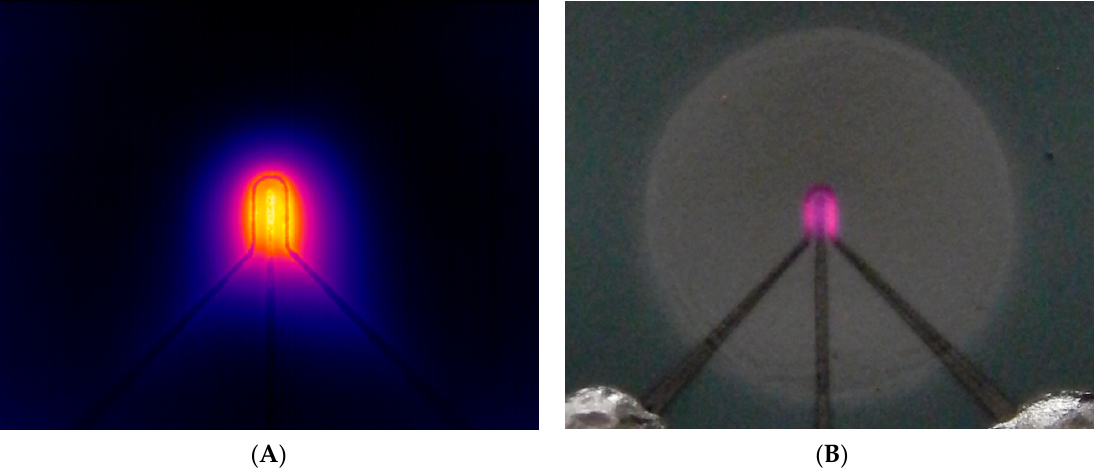
Figure 14. Thermal radiation image of the hot part of the microheater operating at a power of 200 mW, acquired with a FLIR SC655 thermal imaging camera ( A ), and an image of the same microheater operating at the same power, taken with a Nikon Coolpix L820 digital camera ( B ).